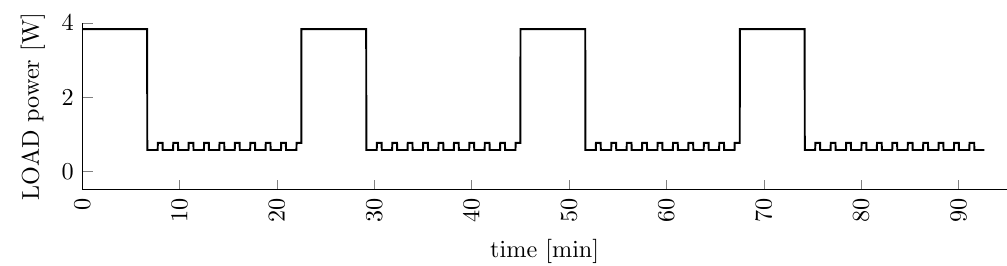
Figure 10. Load profile over an orbital period for the excess energy management